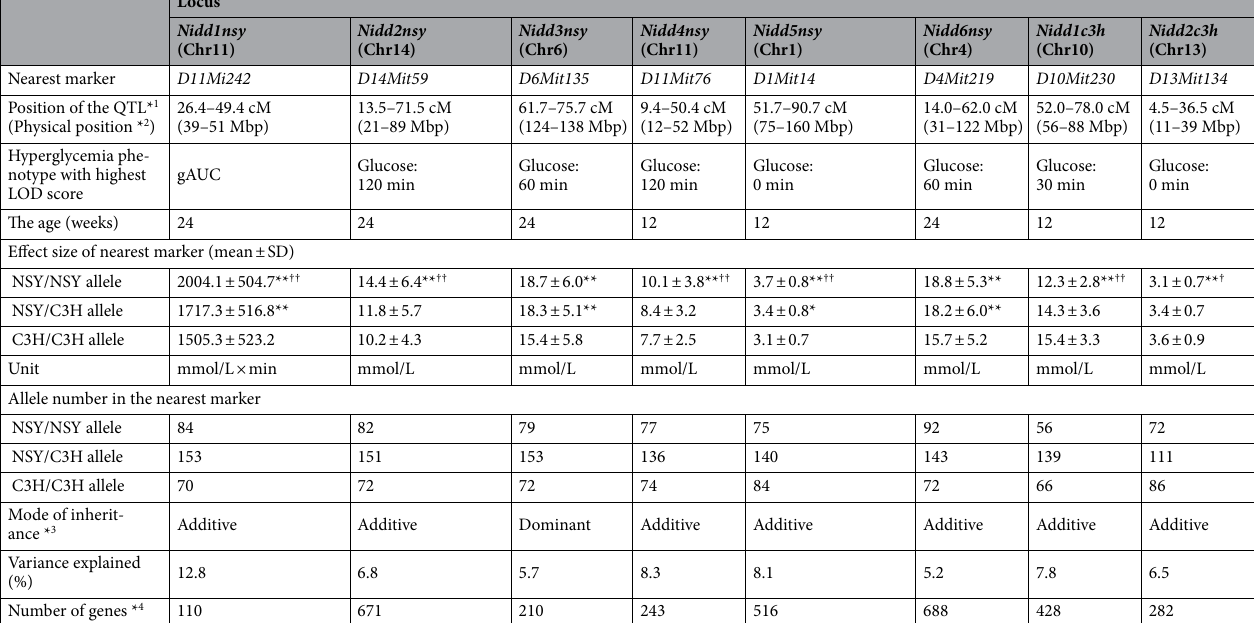
Table 2. Summary of hyperglycemia QTLs in NSY with C3H mice. * 1 95% confidence interval (CI), corresponding to a 1.8-LOD support interval. * 2 Physical positions were estimated from marker positions. * 3 Mode of inheritance of the NSY allele was determined using the degree of dominance, which is the ratio of the dominance effect to the additive effect (see “Materials and methods” section). * 4 Number of genes in the 95% CI was estimated using the Mouse Genome Database (http:// www. infor matics. jax. org). Values were compared using one-way ANOVA with post hoc test (Bonferroni): * P < 0.05, ** P < 0.01 vs CC; † P < 0.05, †† P < 0.01 vs